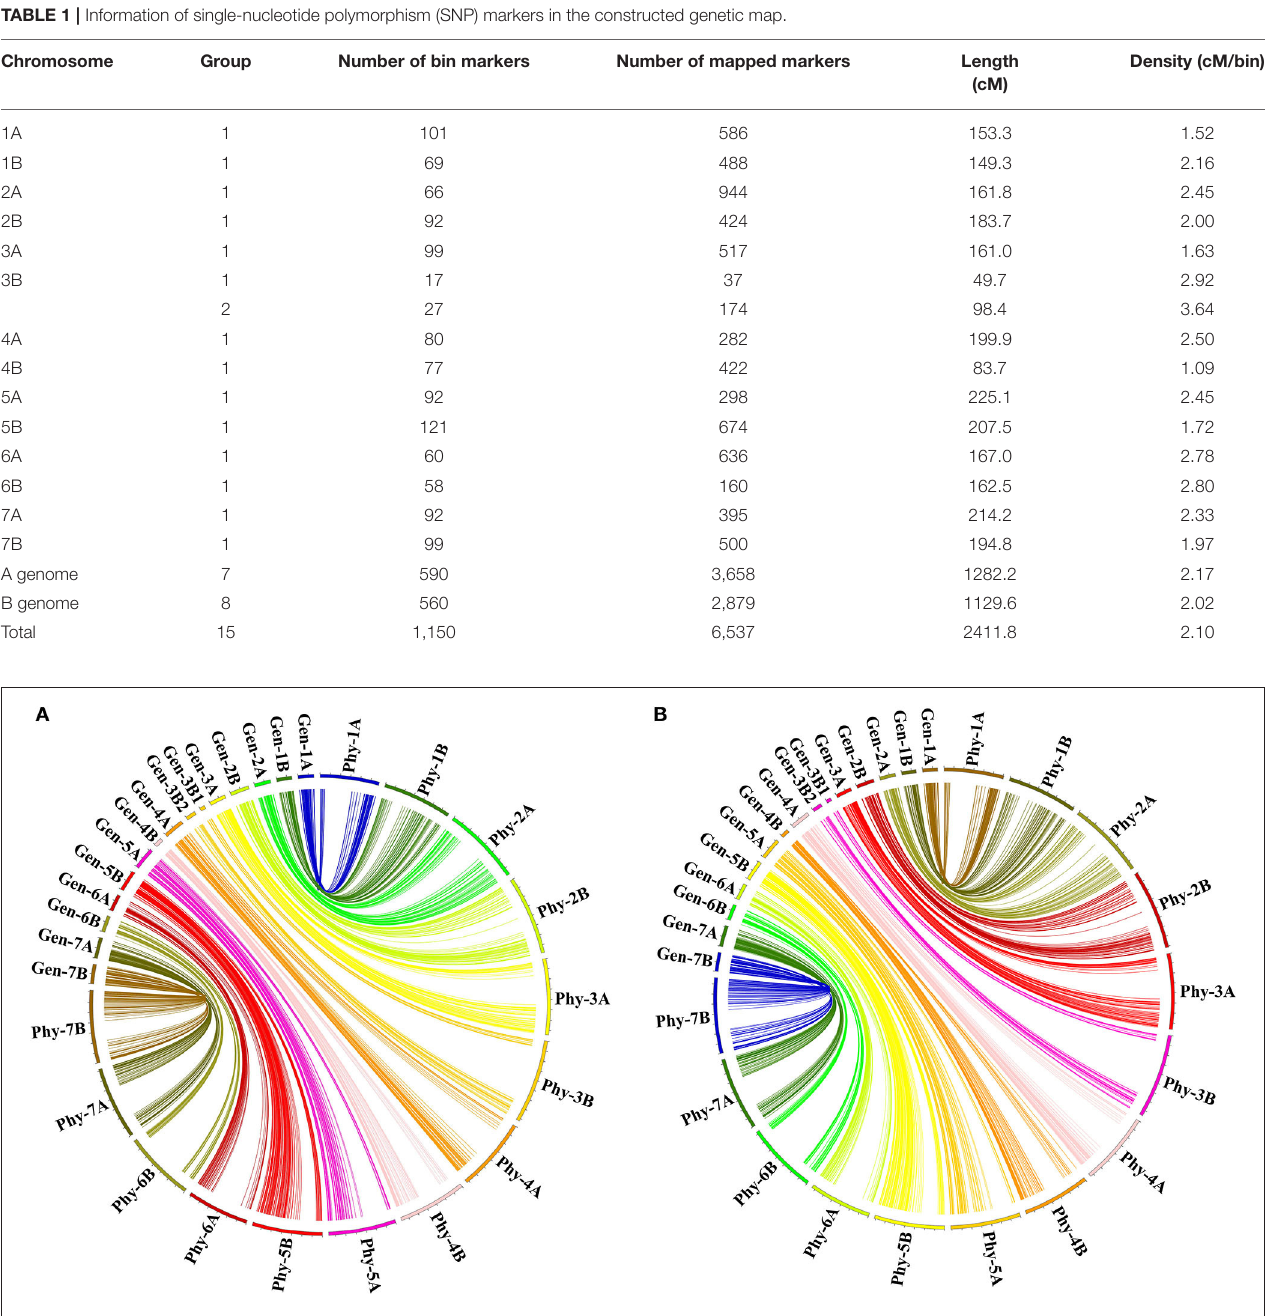
QSns.sau-AM-5A was detected in five environments and located in a 19.1-cM region between AX-108790581 and AX-111596791. It accounted for 8.27–12.09% of the phenotypic variation ( Table 4 ). AM population was divided into two haplotype groups based on the genotype of the flanking markers of QTLs, and the positive